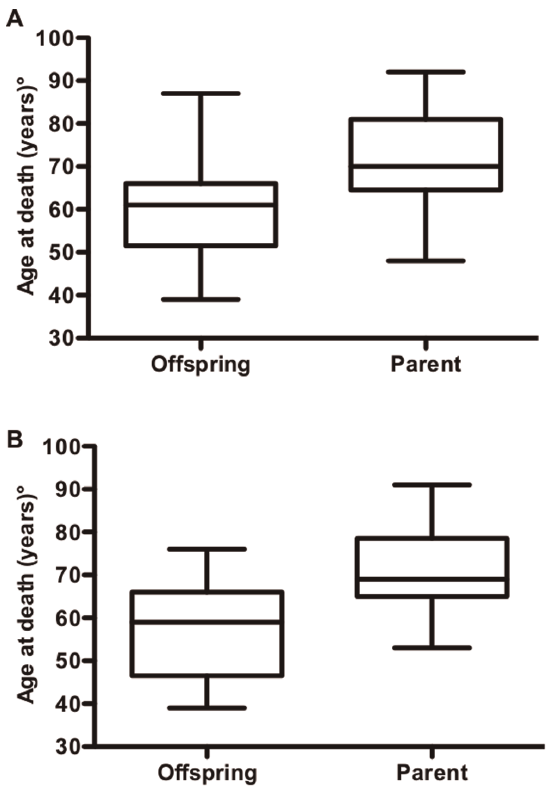
Figure 2. Age at death of offspring and parent generation. Box plots representing the age at death (or at the last clinical evaluation) for all offspring/parent pairs (a) or for pairs where parents had CJD, carried the E200K mutation, or were obligate carrier (b). The boxes extends from the 25th to the 75th percentile, bars extends to upper and lower adjacent values, and the lines in the middle of boxes represent the median value.